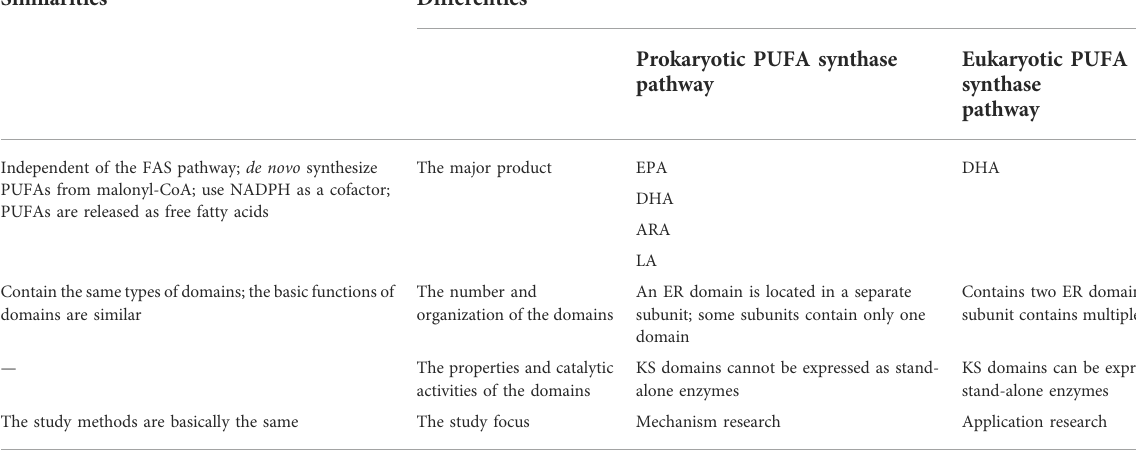
TABLE 2 Similarities and differences between prokaryotic and eukaryotic PUFA synthase pathways.